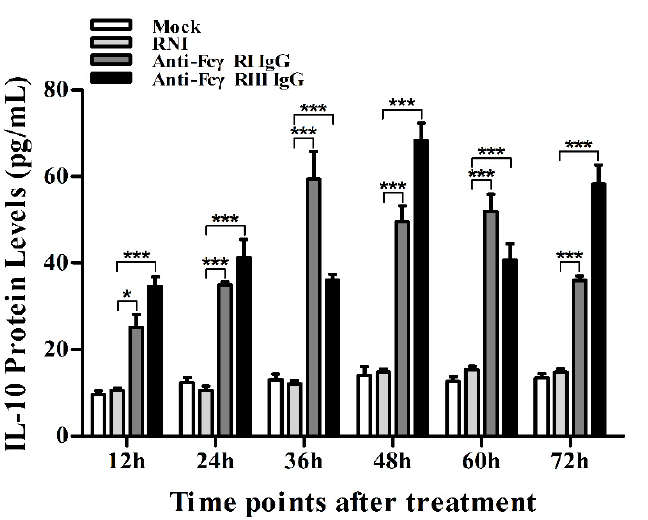
Figure 10. Effect of Fc γ RI or Fc γ RIII on protein expression of IL-10 in porcine AMs. IL-10 protein level in culture supernatants of cells treated with RNI, anti-Fc γ RI IgG or anti-Fc γ RIII IgG was detected by using the IL-10 ELISA Kit. *** p < 0.001, * p < 0.05.